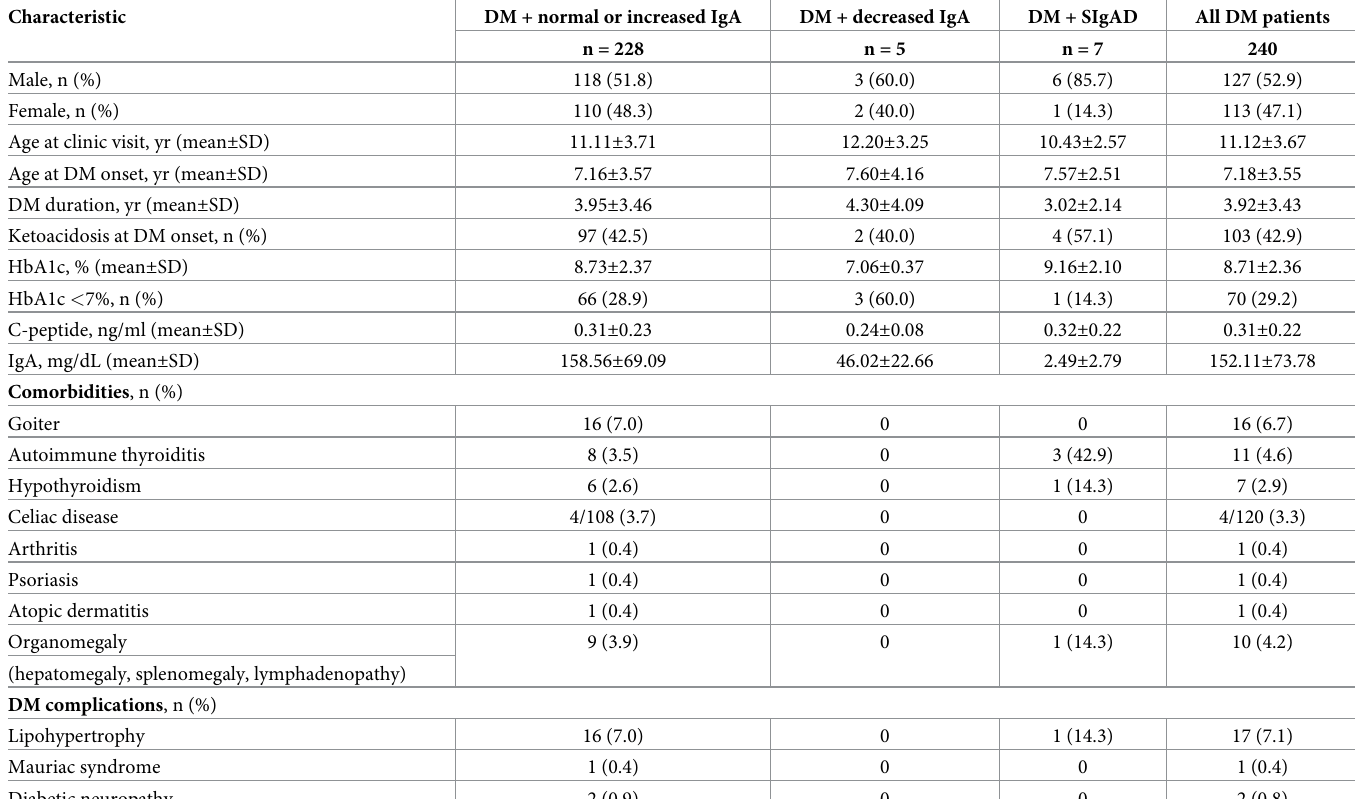
Table 1. Baseline characteristics of the patients with